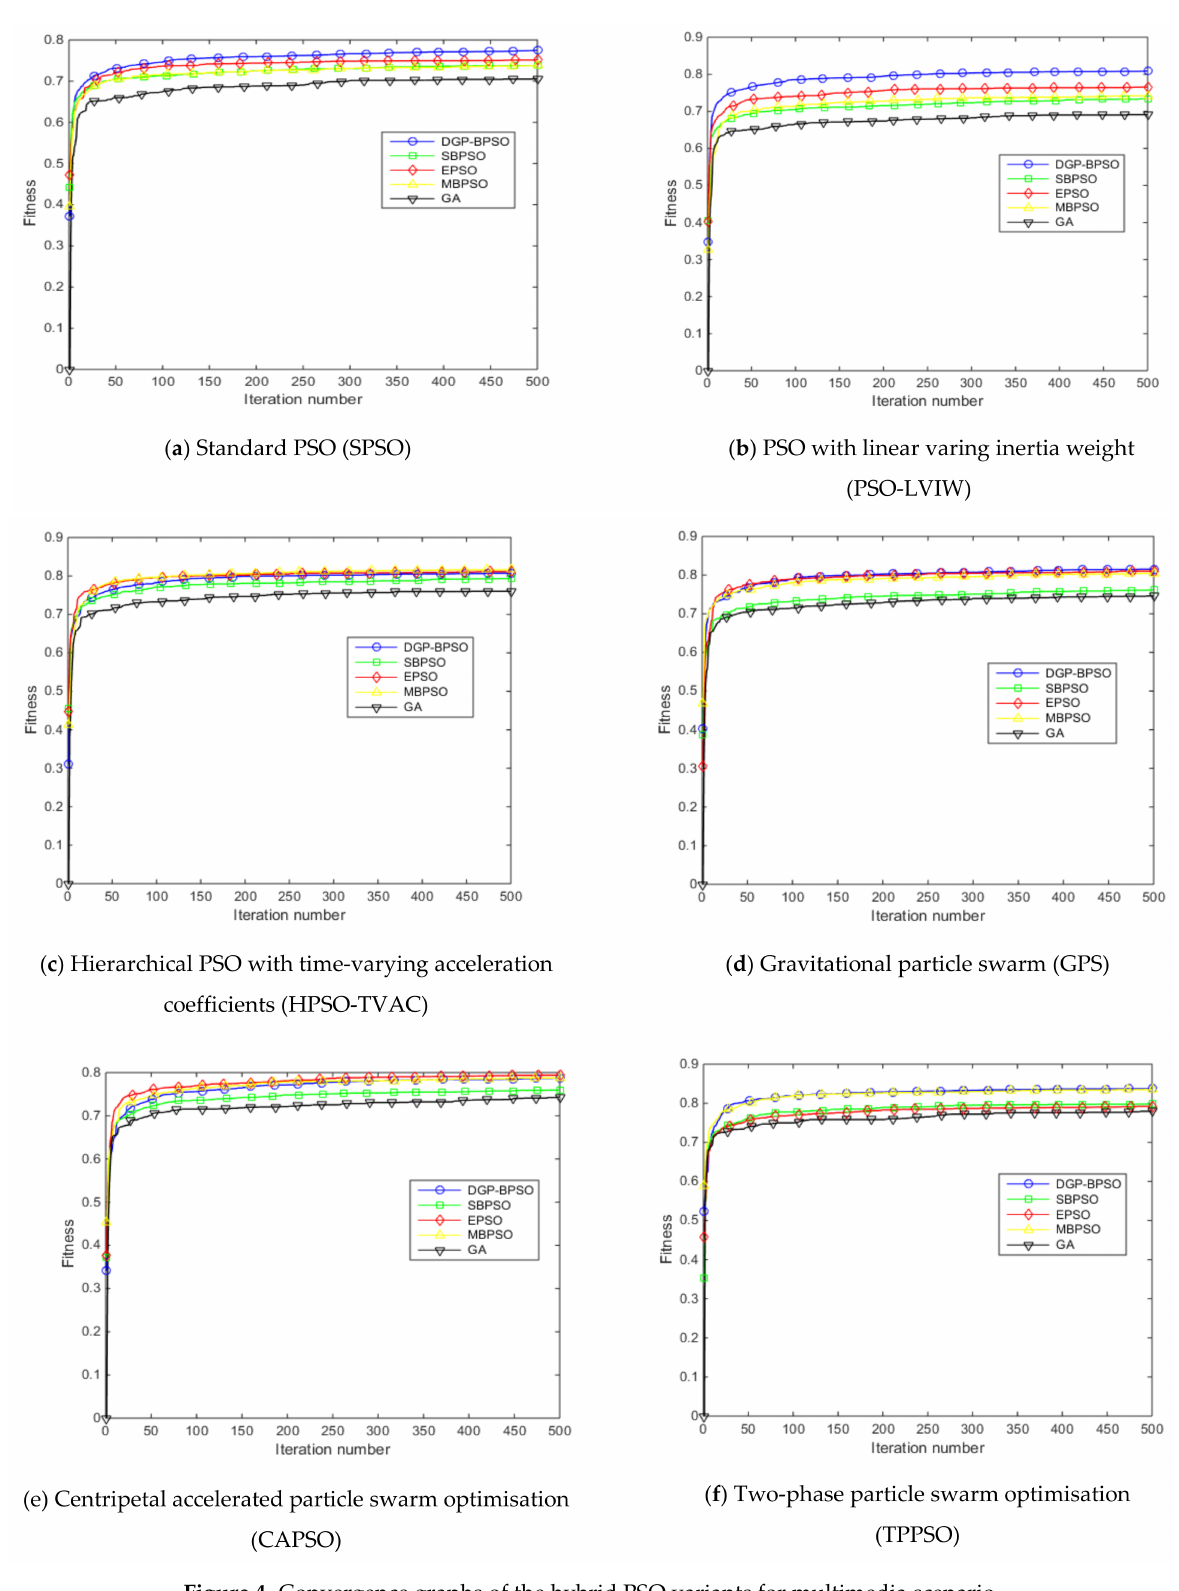
Figure 4. Convergence graphs of the hybrid PSO variants for multimedia